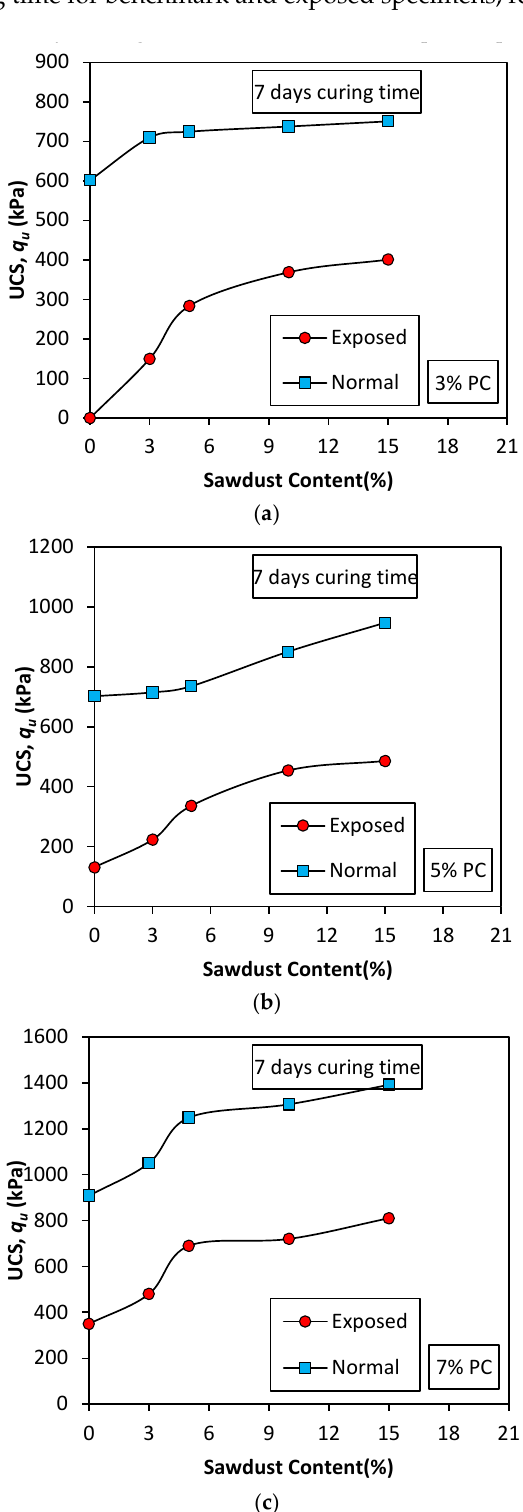
Figure 7. E ff ect of sawdust addition on USC peak values (7 days curing) ( a ) 3% PC; ( b ) 5% PC; ( c ) 7%